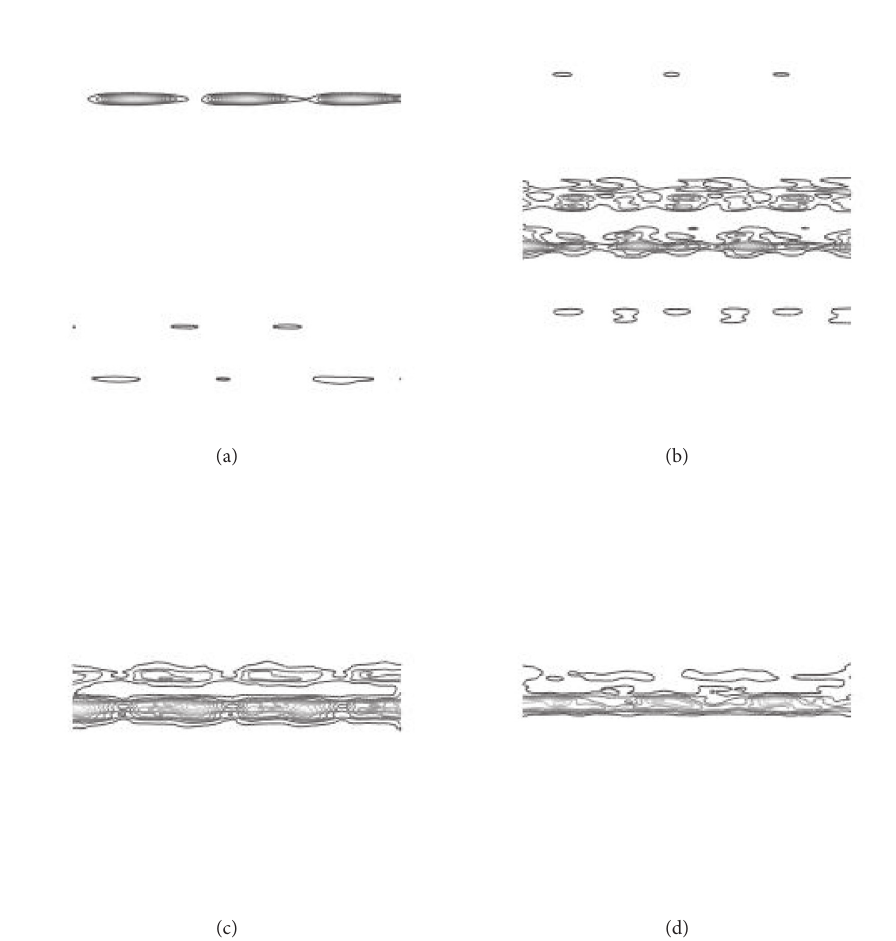
Figure 5: EP sample: (a) normal state; (b) inner ring fault; (c) outer ring fault; (d) rolling body fault.